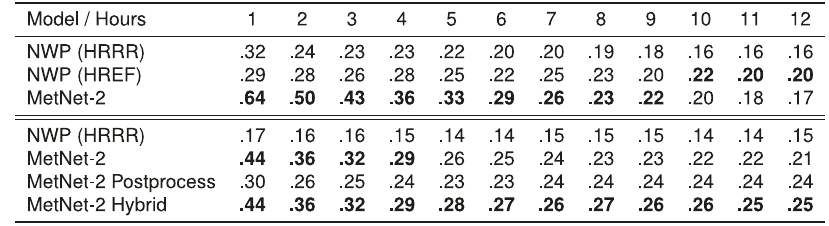
Fig. 3 | Numerical results for the models (datasets A and B). Critical Success Index scores of HRRR, HREF and MetNet-2 for cumulative precipitation on dataset A ( fi rst three rows) and of NWP (HRRR) and MetNet-2 variants for instantaneous